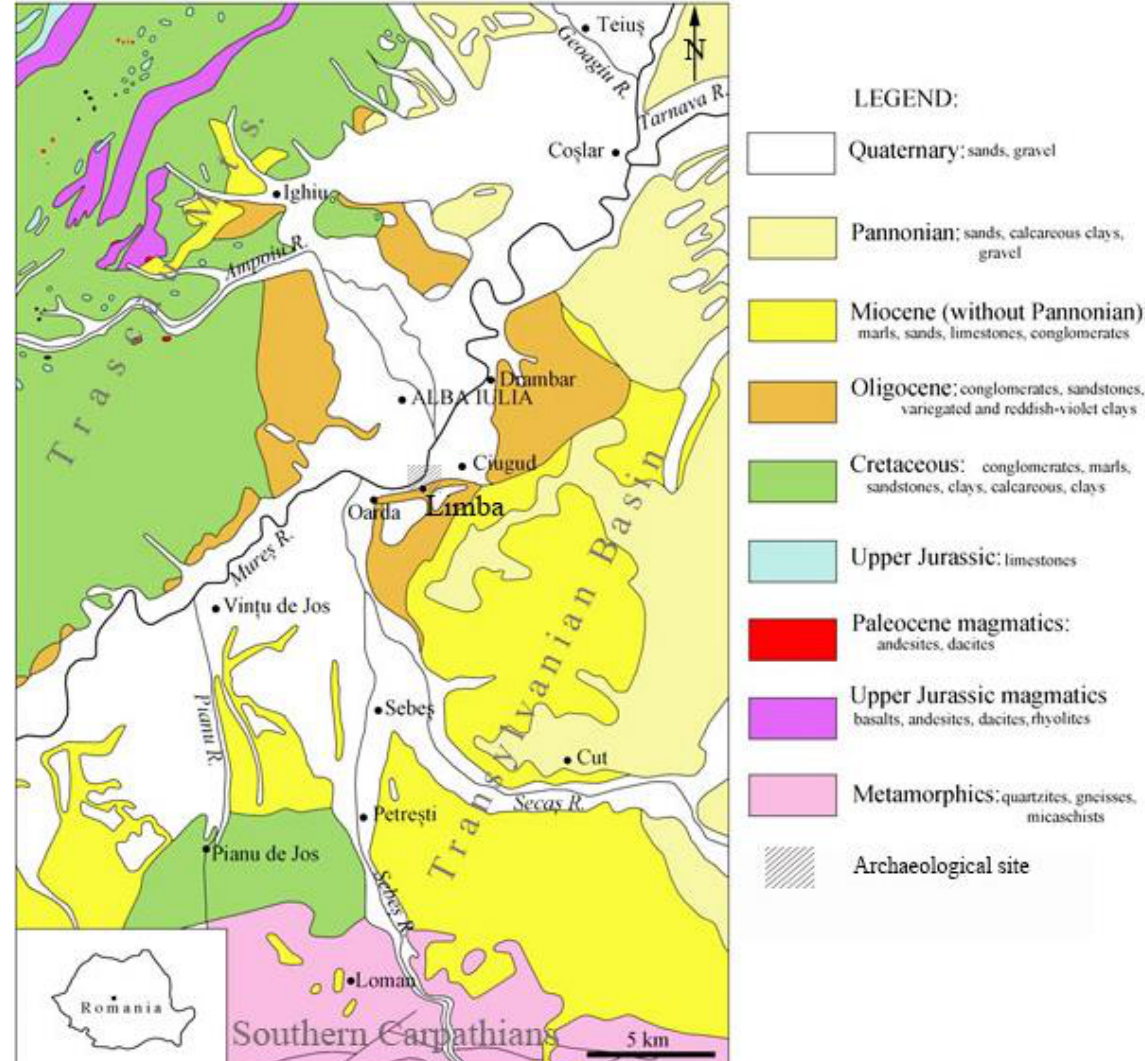
Figure 1. Location of the Vinča site at Limba-Oarda de Jos on a simplified geological map (according to Giușcă et al. 1967) of the area. The inset in the lower left shows the position of the area within Romania. Legend: Quaternary: sands, gravel. Pannonian: sands, calcareous clays, gravel. Miocene (without Pannonian): marls, sands, limestones, conglomerates. Oligocene: conglomerates, sandstones, variegated and reddish-violet clays. Cretaceous: conglomerates, marls, sandstones, clays, calcareous clays. Upper Jurassic: limestones. Paleocene magmatics: andesites, dacites. Upper Jurassic magmatics: basalts, andesites, dacites, rhyolites. Metamorphics: quartzites, gneisses,